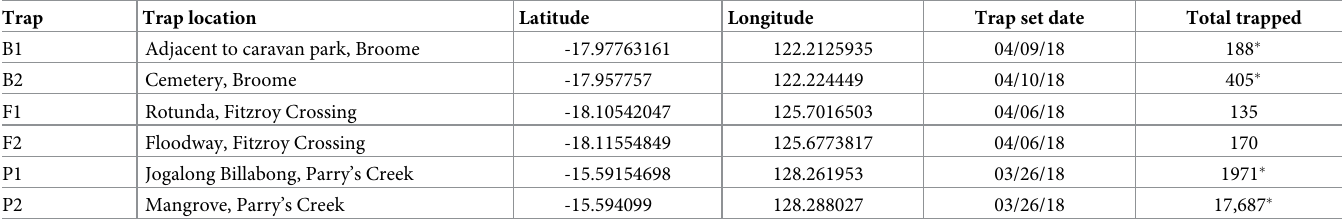
Table 1. Culex annulirostris trapped from three sites in the Kimberley